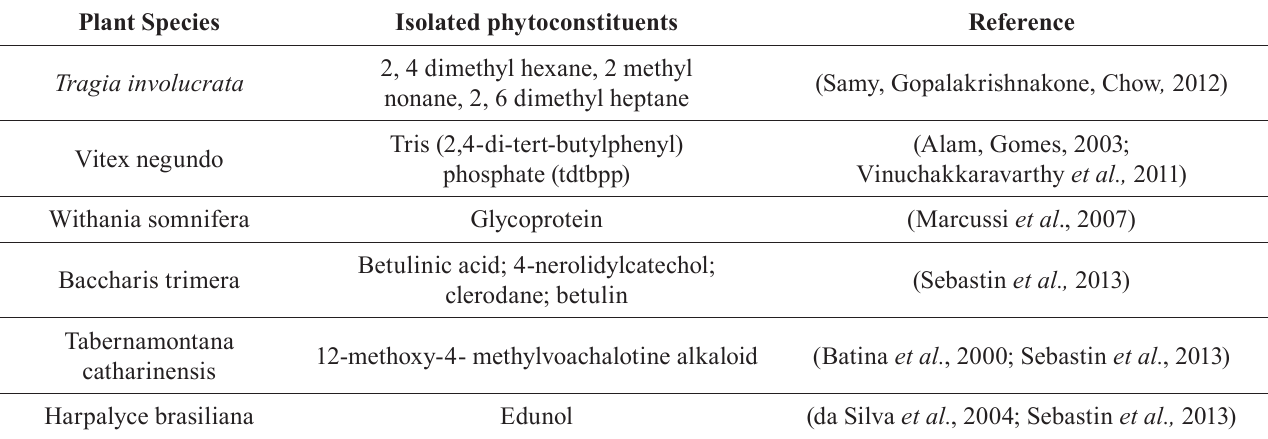
TABLE III - Phytoconstituents of traditional plants with antivenom